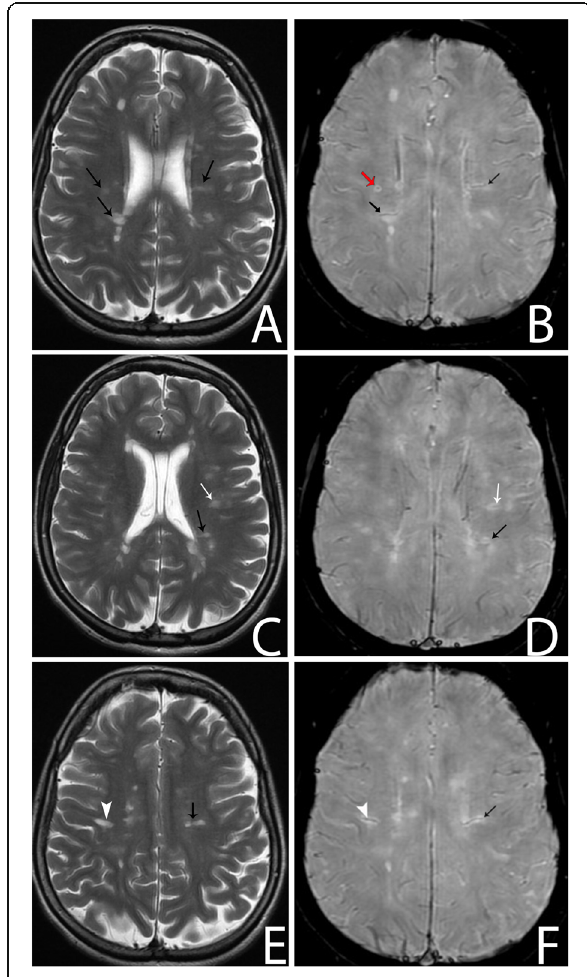
Fig. 2 Axial ( a , c e ) T2WI images show hyperintense MS periventricular (black arrows), deep white matter (arrowhead), and juxta-cortical lesions (white arrow). On corresponding ( b , d f ) SWI images, a thin hypointense line representing the CVS is seen within the periventricular (black arrows), deep white matter (arrowhead), and juxta-cortical lesions (white arrow) while a central hypointense dot in the right periventricular lesion (red arrow)